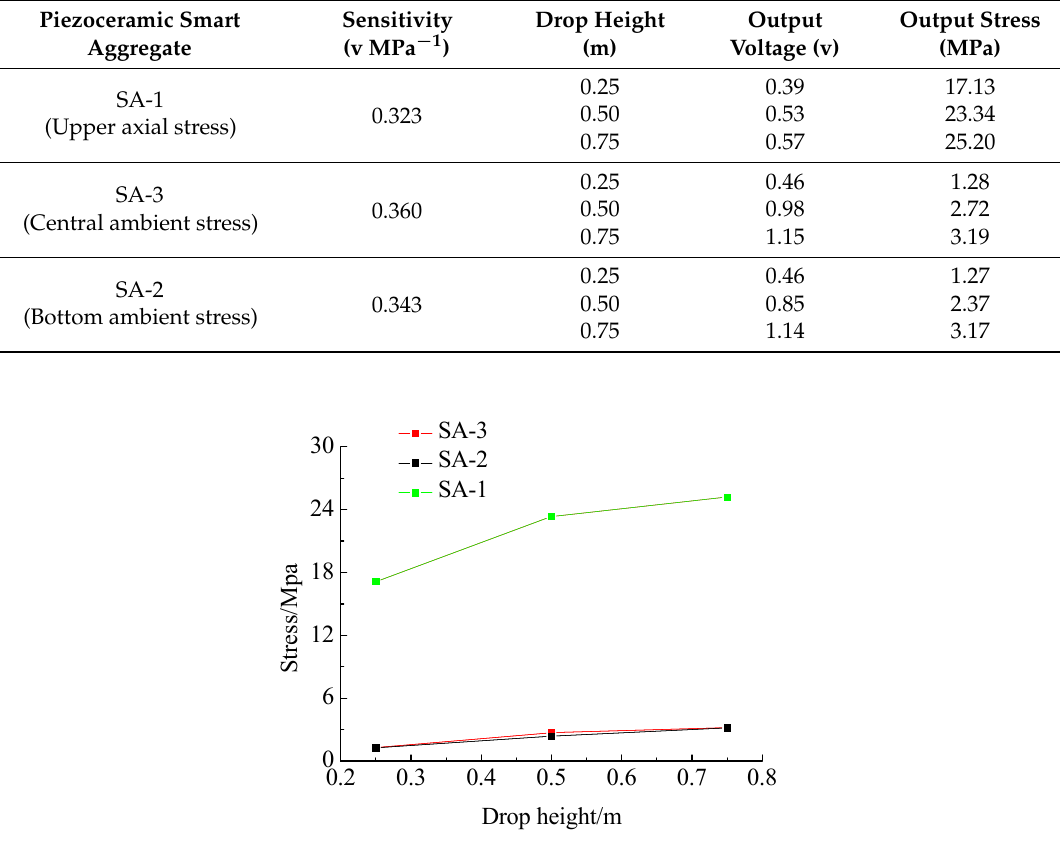
Table 5. Test results of smart aggregate output.